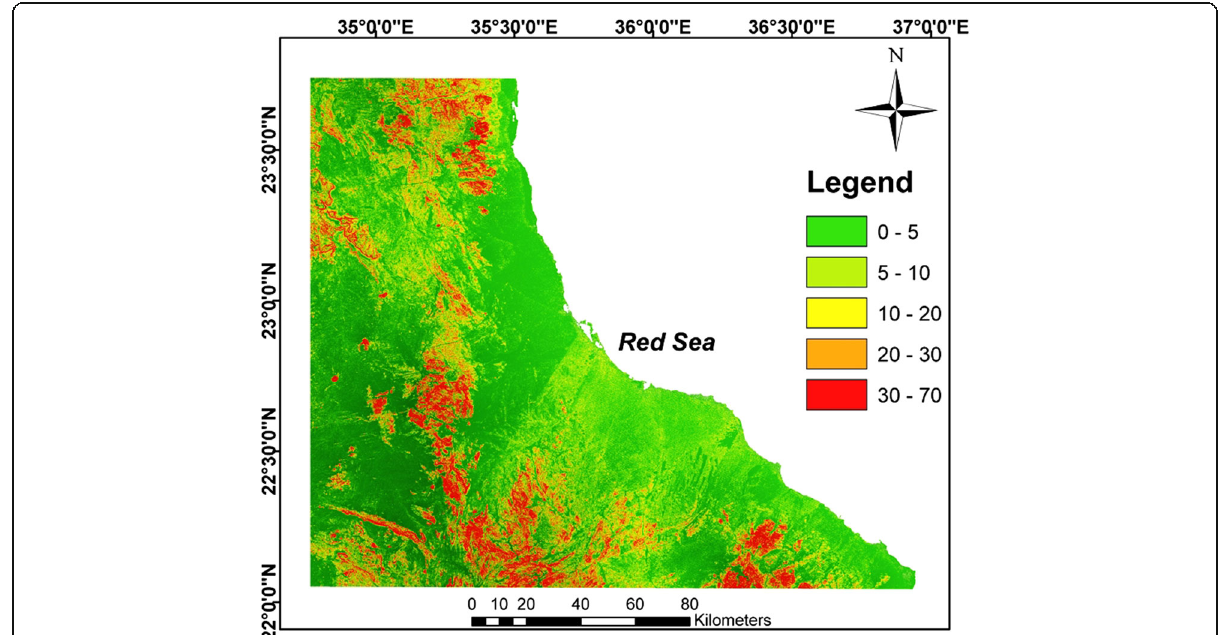
Fig. 12 Slope layer by degree shows classes ranging from gentle to steep slopes due to the relief